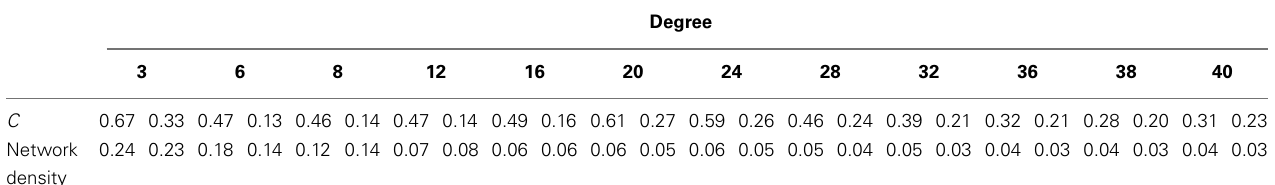
TableA1 |The degree and clustering coefficient values of the target nodes, and the density values of the two-hop networks used in the present